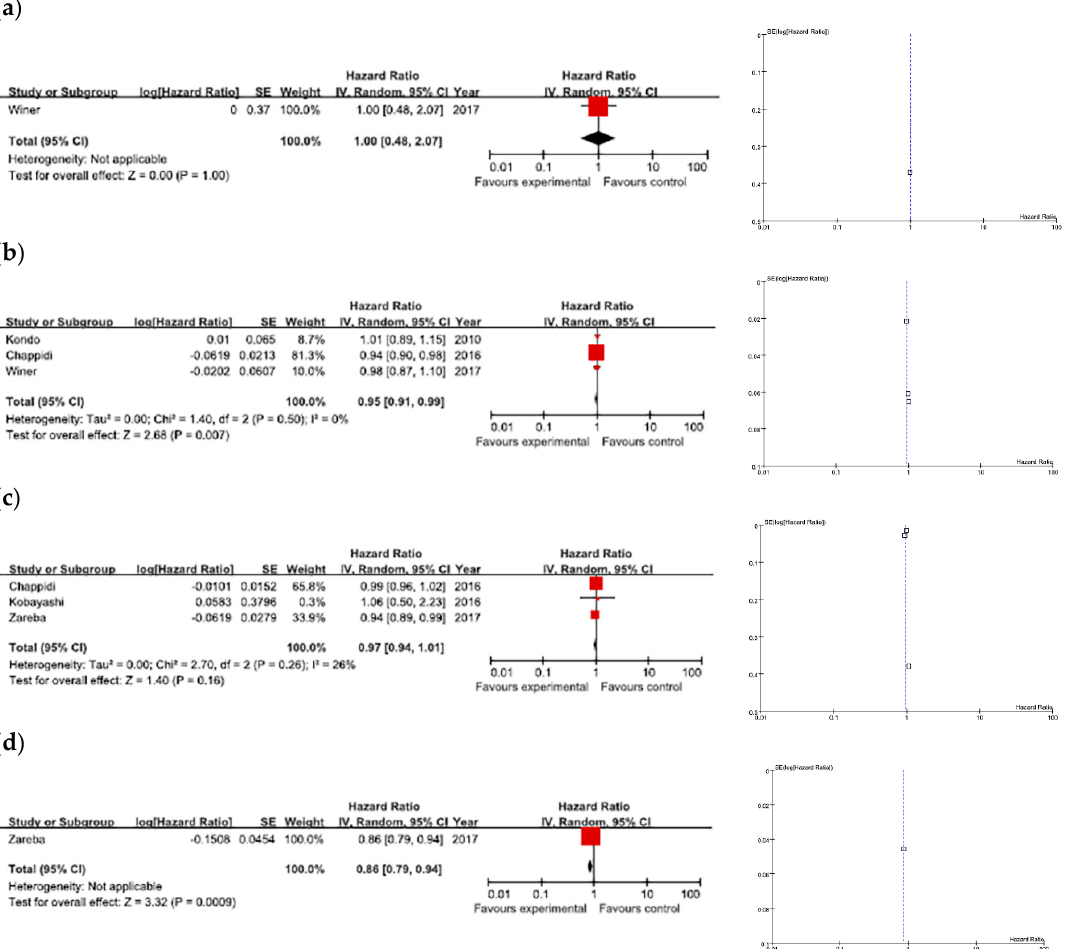
Figure 2. Forest plots of survival outcomes according to the number of lymph nodes removed, and funnel plots. ( a ) Cancer-specific survival, ( b ) overall survival, ( c ) progression-free survival, and ( d ) overall survival among N0 patients.